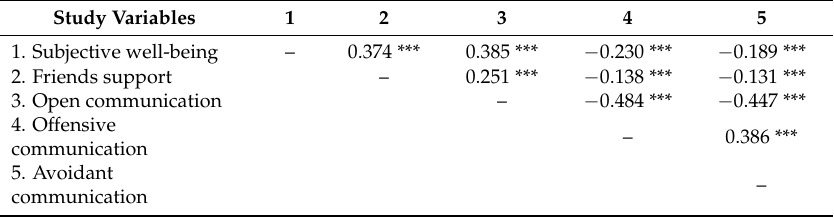
Table 2. Correlational analyses among the study variables.